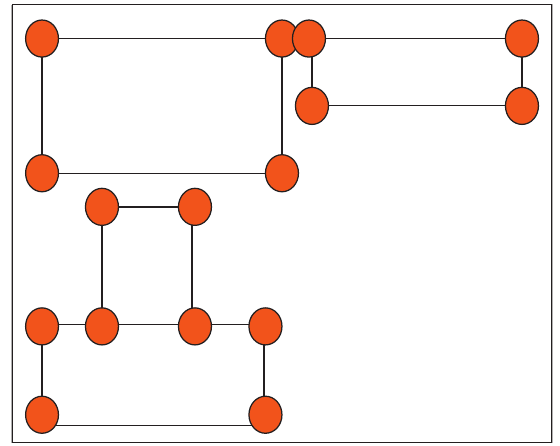
Figure 5: House corner extraction effect map.